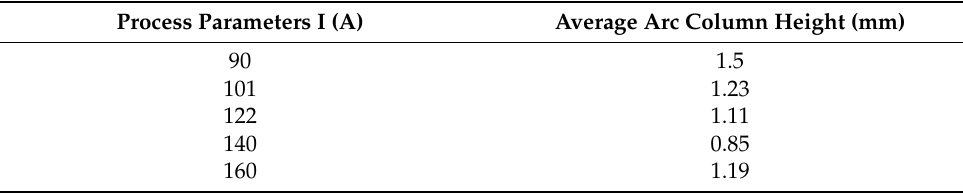
Figure 7. Graphs: ( a )—average arc burning time, ( b )—average short circuit time, ( c )—average peak short circuit current, ( d )—average droplet diameter dependance on the set current parameters. Table 2. The welding current influence on the arc height at U=20 V.